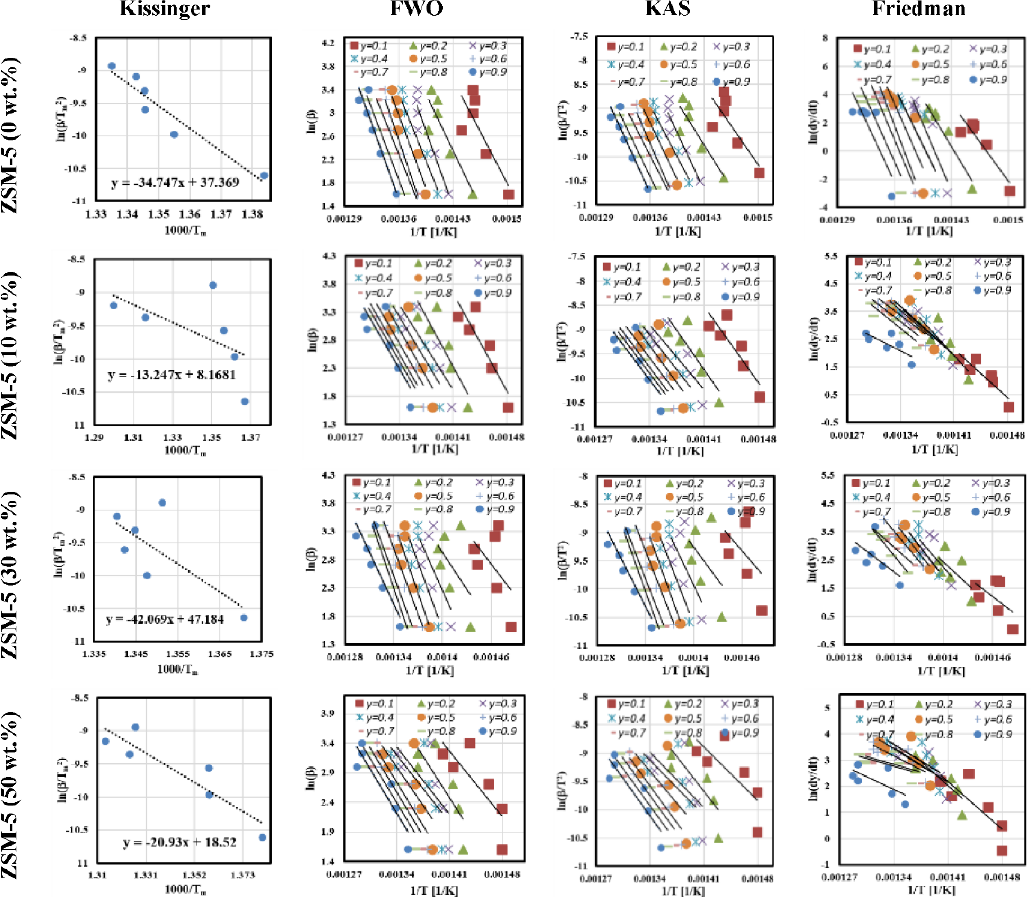
Figure 5. Plots of isoconversional and model-free methods curves.